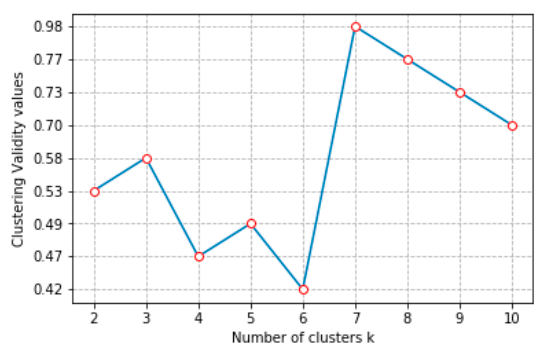
Figure 7. Validity values in di ff erent numbers of clusters by using